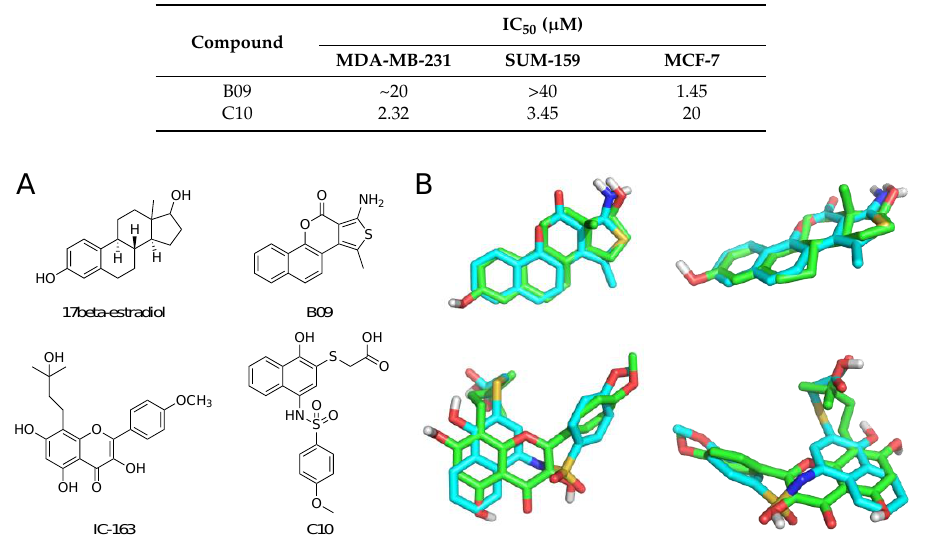
Table 1. Activities of B09 and C10 measured on different cell lines.